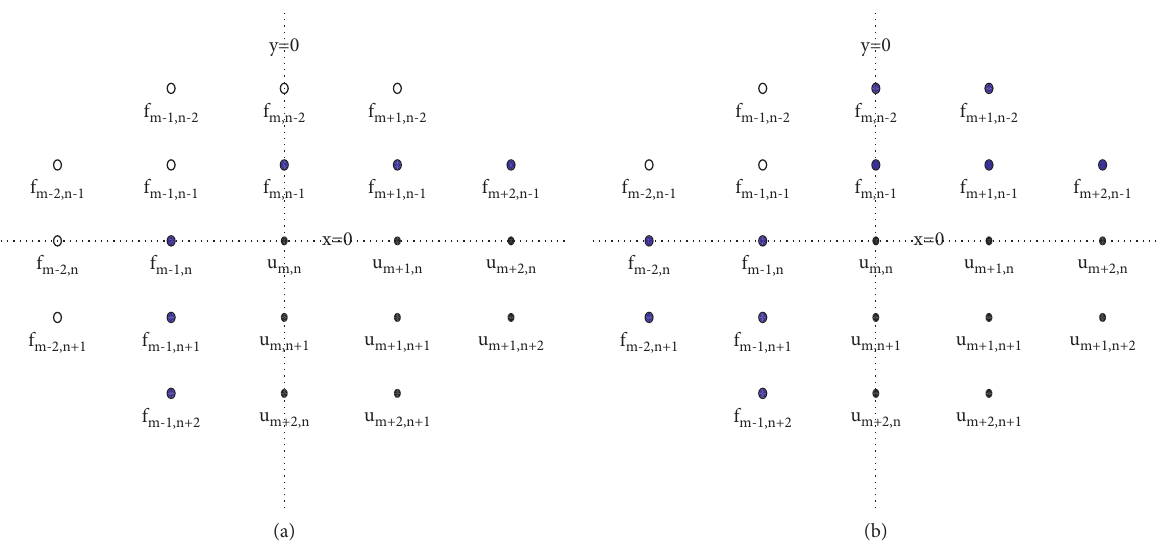
Figure 5: Illustration of the MIB iterative procedure for the new 21-point scheme. (a) The first step. (b) The second step.